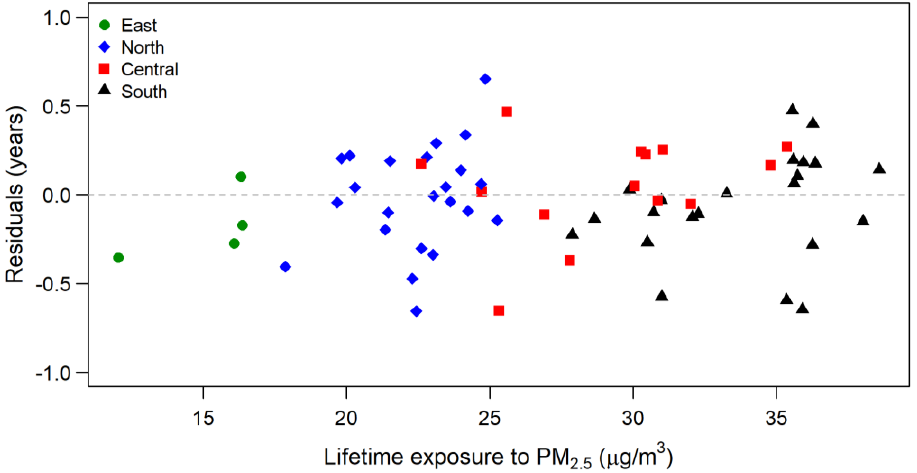
Figure 3. Residuals of the fitted regression model plotted against expected lifetime exposure to PM 2.5 for the cohorts in the 63 study areas.